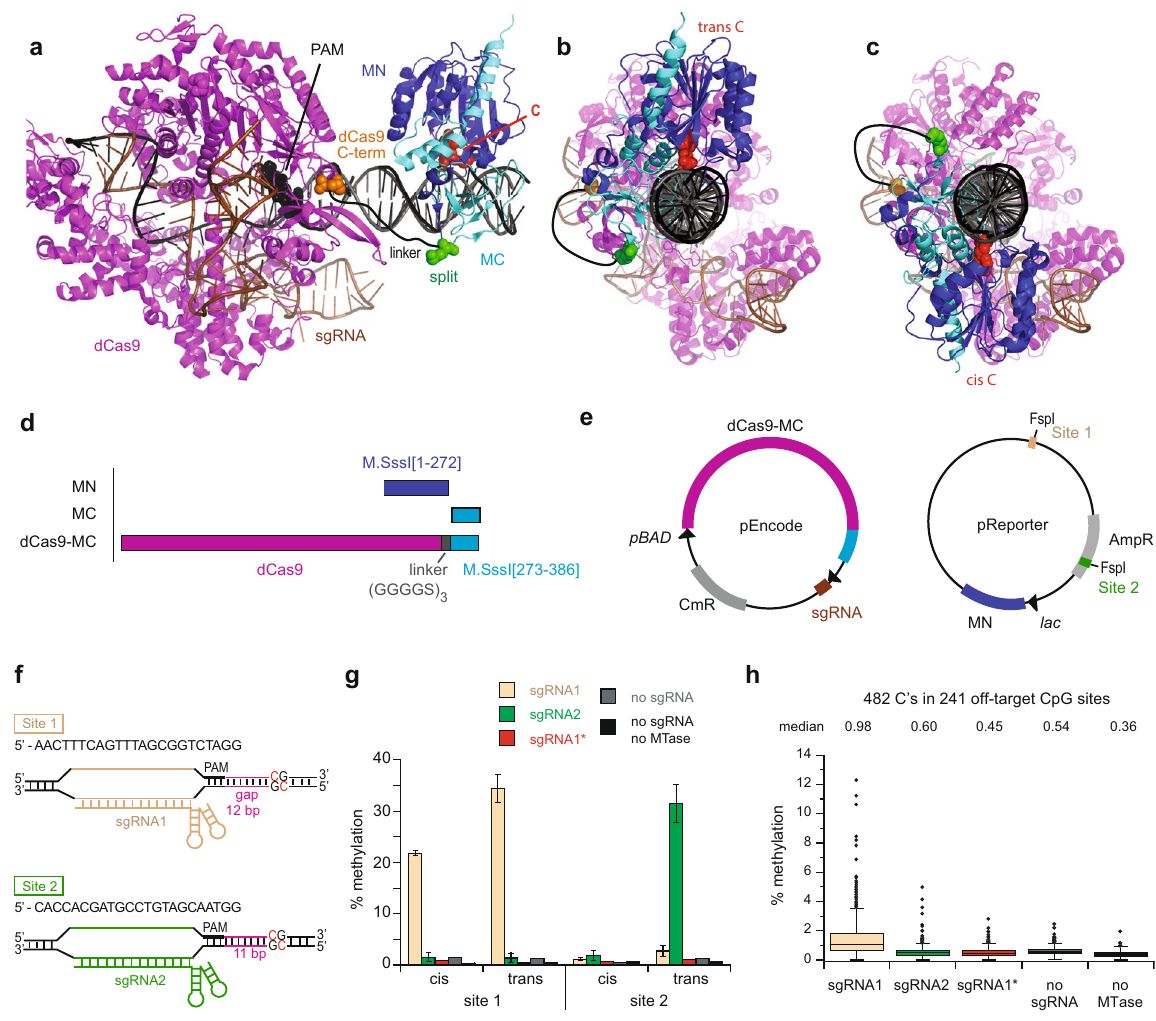
Rules for sgRNA design for targeted methylation. At the target site, sgRNA1 directed methylation to both cis and trans strands, albeit at different levels, but sgRNA2 effectively caused methylation only on the trans strand (Fig. 1g). As site 1 and site 2 had different gap lengths between the PAM and the CpG site, this dif- ference suggested that the spatial relationship between the PAM site and each strand of the CpG site determined methylation efficiency. This observation led us to systematically explore how gap length affected methylation efficiency on both strands. We determined dCas9-MC/MN’s ability to methylate each C in a CpG site positioned 2 to 42 base pairs from the PAM site (Fig. 2). We found that methylation did not occur if the CpG site was less